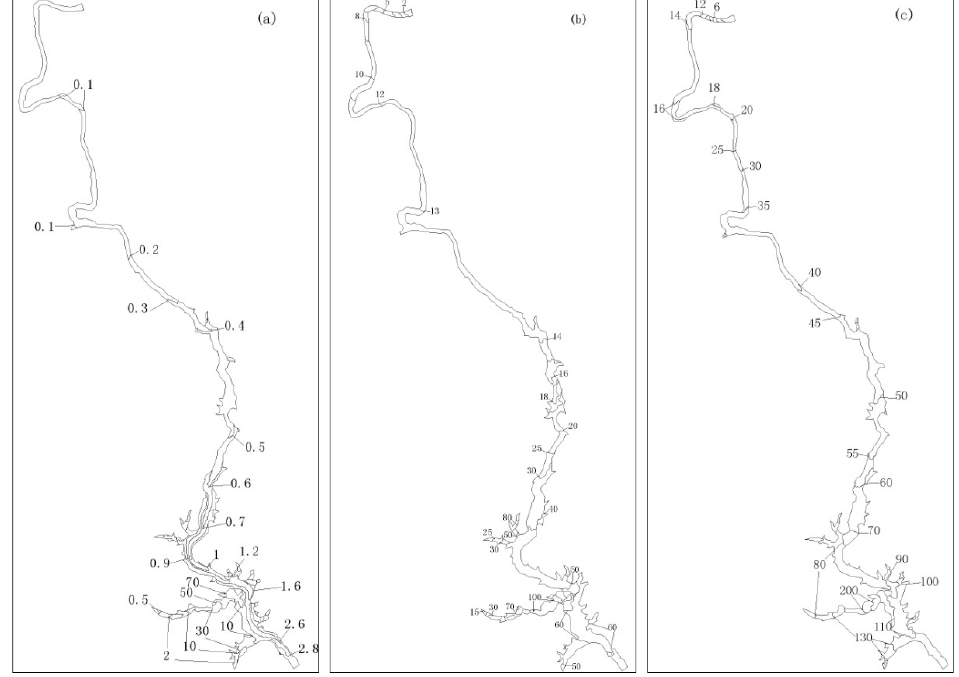
Figure 7. Time series of water age in different typical years, about 200 m far away from CTR dam. ( a ) the spatial distribution of water ages in wet year; ( b ) the spatial distribution of water ages in average year; ( c ) the spatial distribution of water ages in dry year.